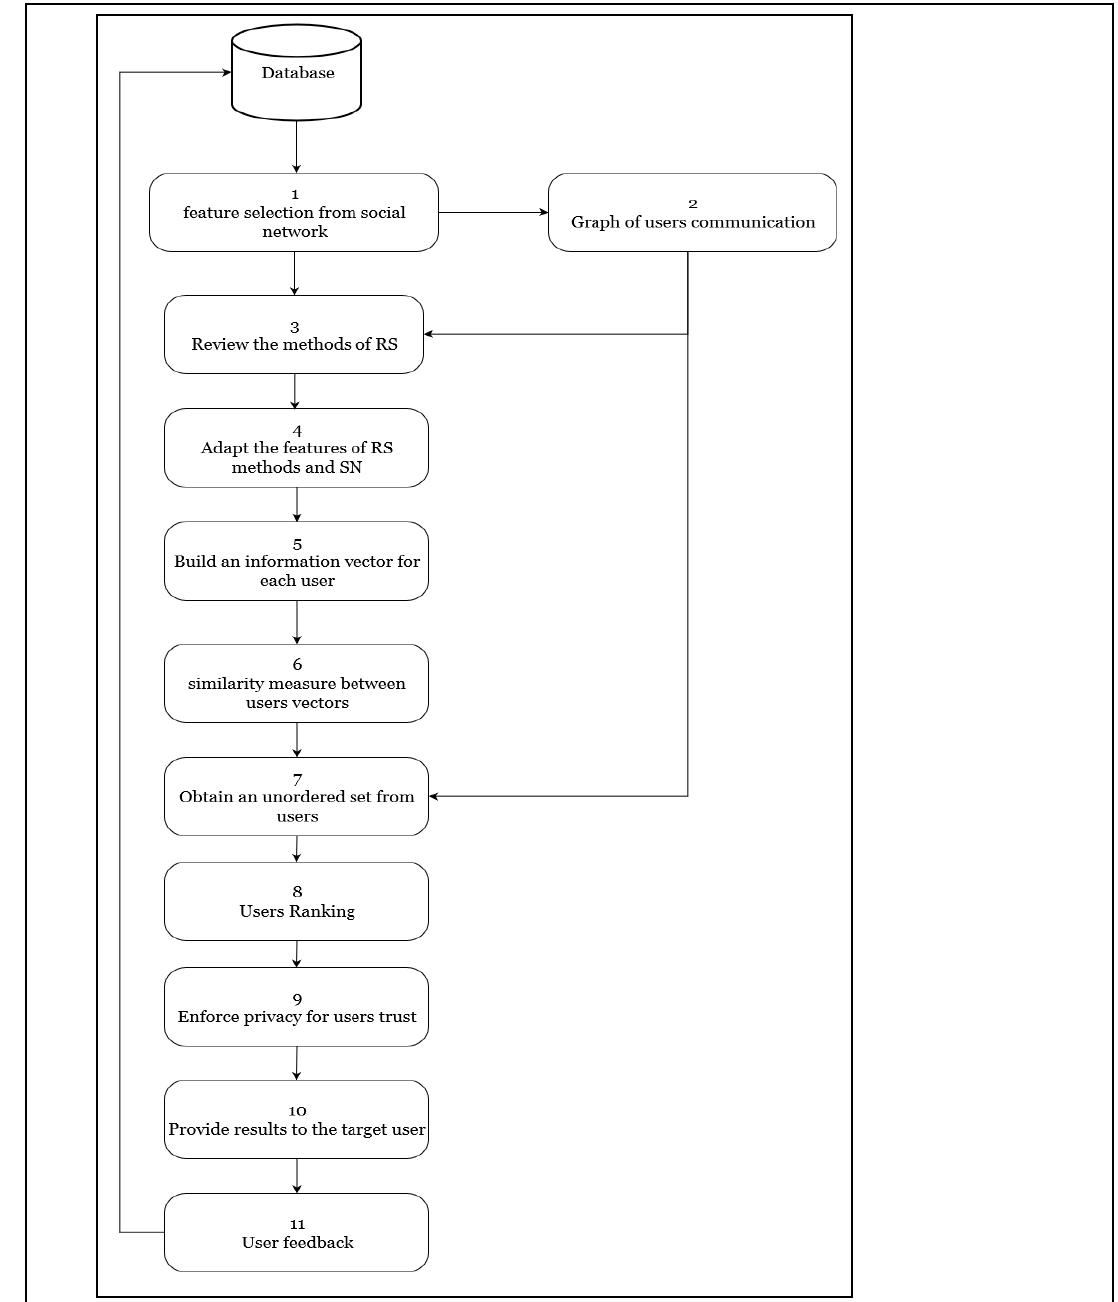
Figure 2. Generic template Friend